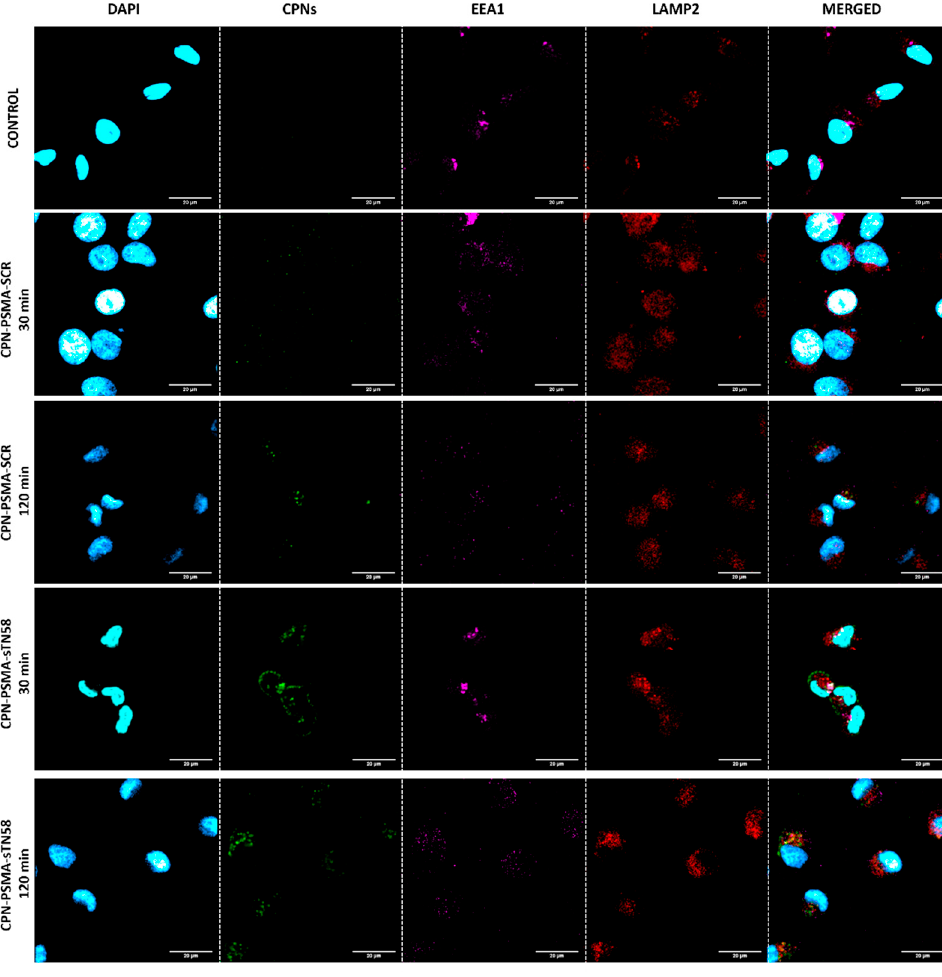
Figure 6. Endosomal traffic assay with aptamer-decorated CPNs in TNBC cells. Representative confocal images of MDA-MB-231/cis cells exposed to different aptamer-decorated CPNs (2 mg/L) for 30 min, and then early endosome and late endosome/lysosomes were stained at 30 and 120 min.